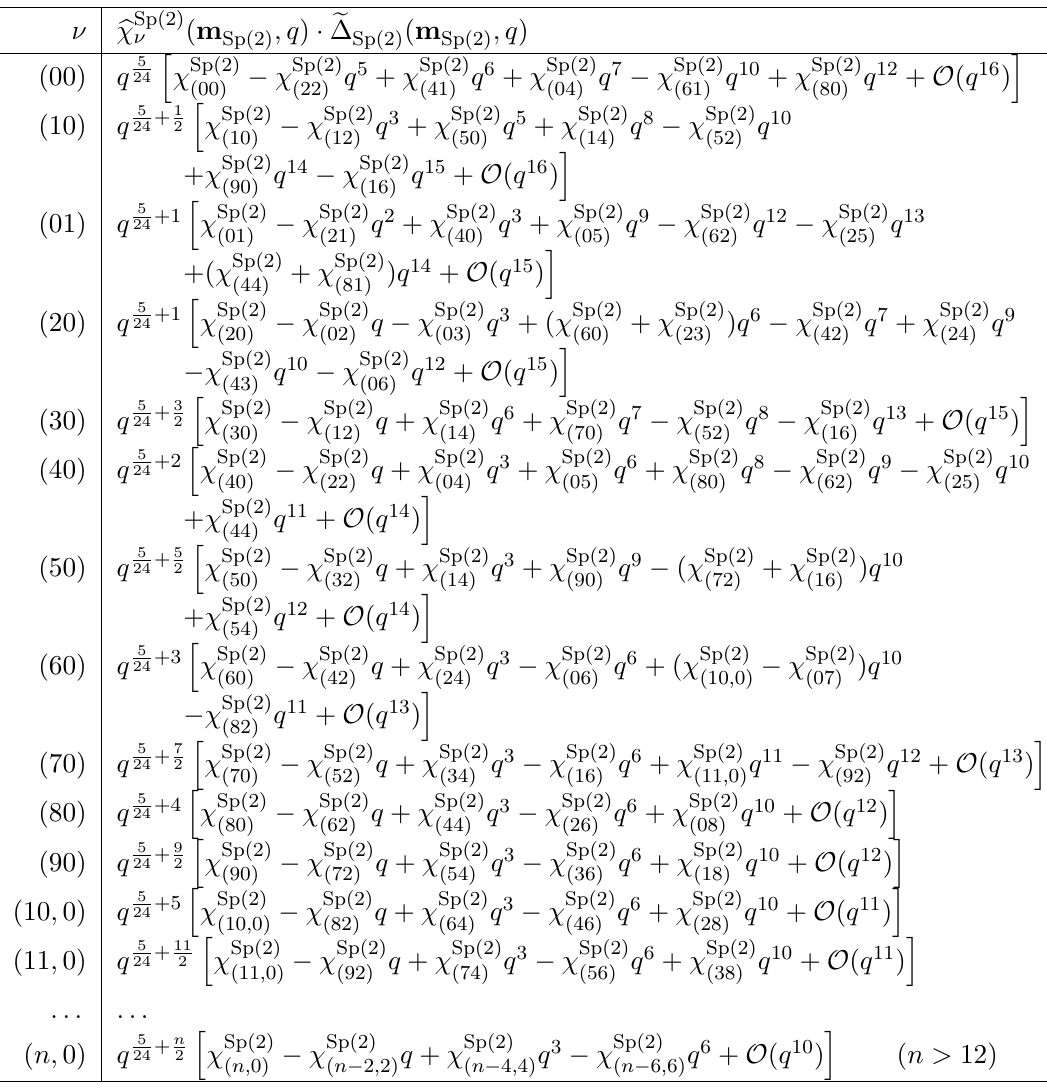
Table 15. Irreducible characters of Sp(2) at level (cid:0) 1 (rescaled by an overall factor of e (cid:1) Sp(2) ( m Sp(2) ; q )), computed up to O ( q 5 24 +16 ). For n su(cid:14)ciently high, the leading order terms in the (cid:23) = ( n; 0) representation behave regularly, as indicated in the last entry; we have checked the validity of this formula up to O ( q 5 24 +16 ) for n (cid:20)